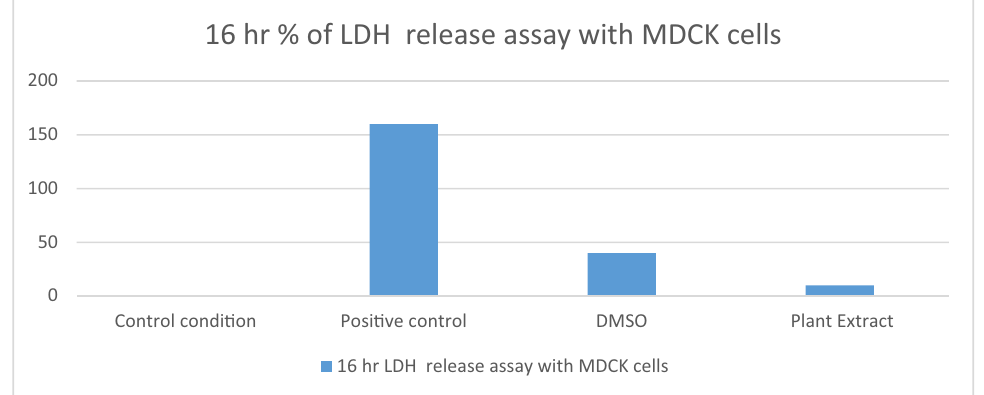
Figure 5: The percentage of LDH release with plant extract, control, DMSO, and positive control after 16 h incubation with MDCK